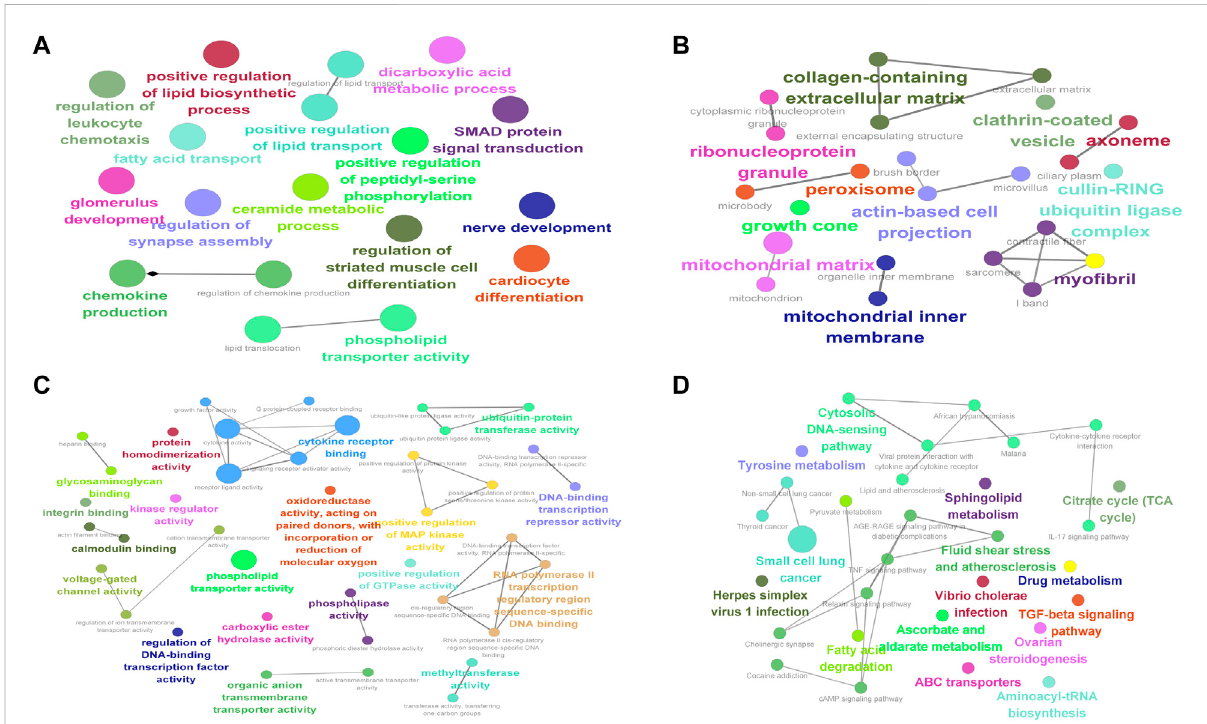
FIGURE 6 Enrichment analysis of differentially expressed mRNAs in muscular atrophy. GO and KEGG enrichment analyses of DE mRNAs. (A) Circle diagram of BP. (B) Circle diagram of CC. (C) Circle diagram ofMF. (D) Circle diagram ofKEGG. The color represents the p -value; thedarker the color is, the smaller the p -value is. The size of the circle represents the number of genes. BP, biological process; CC, cellular component; MF, molecular function; KEGG, Kyoto Encyclopedia of Genes and